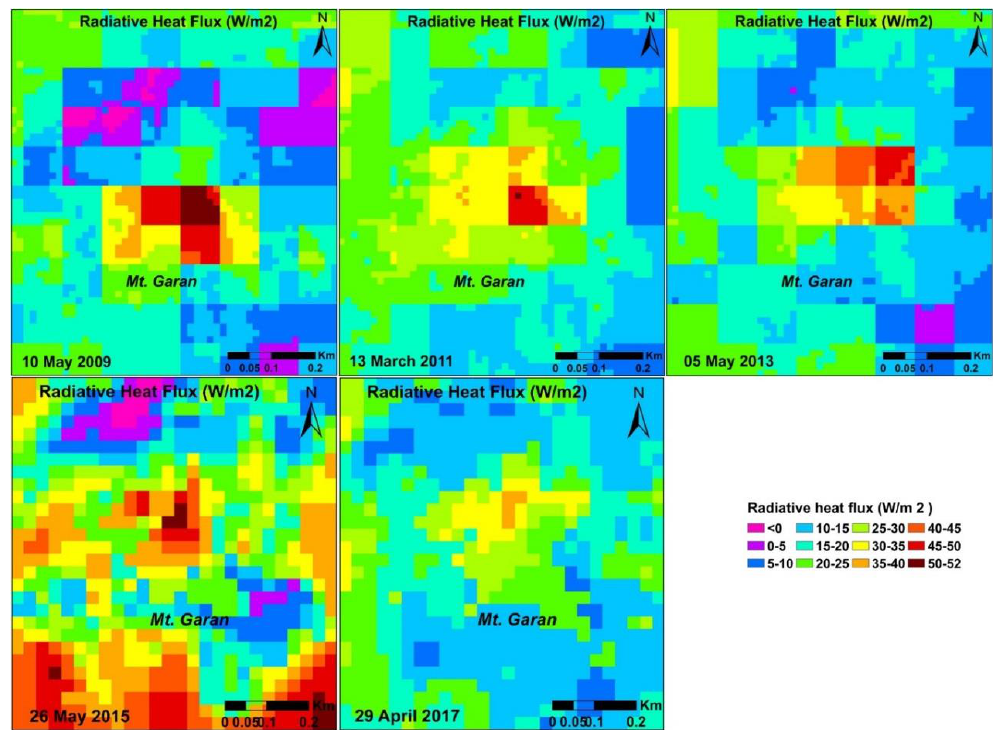
Figure 8. Radiative heat flux maps of the Mt. Garan fumaroles, derived from nighttime ASTER thermal infrared data for 2009, 2011, and 2013 ( top row ), and from nighttime Landsat 8 TIRS data for 2015 and 2017 ( bottom row ).